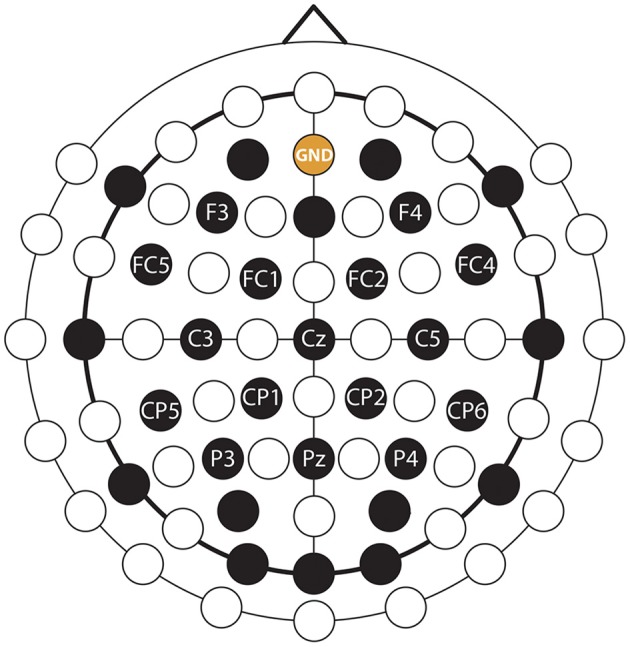
EEG montage. EEG and ground channels used for this study are labeled. Non-labeled black channels were also recorded, but were not used in this study (see the explanation in the text body).